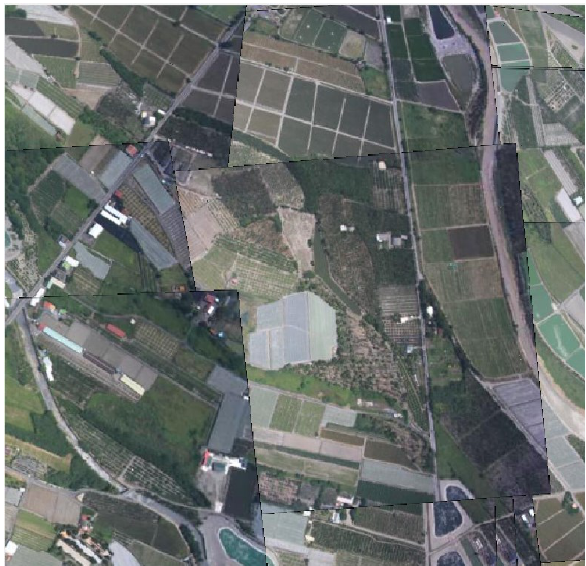
Figure 7. Enlarged view of the bounded area in Figure